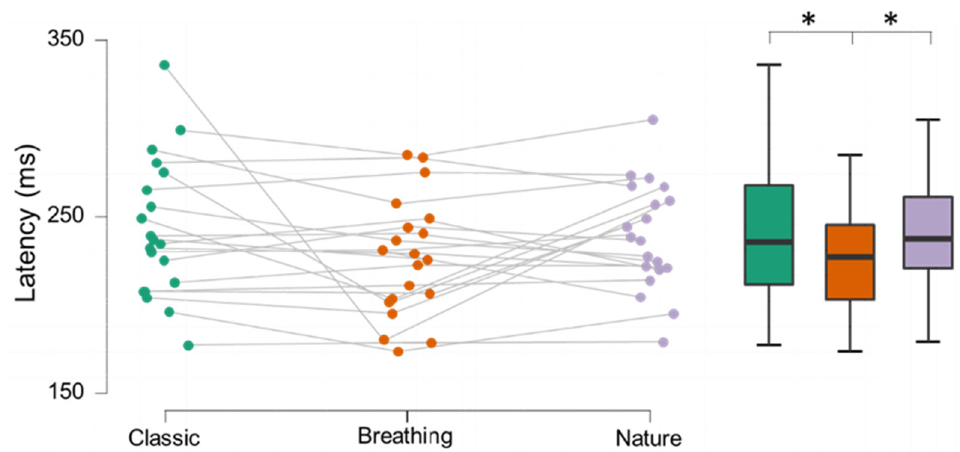
Figure 2. Individual and box plot data for protocol latencies in milliseconds. Breathing showed significantly lower latencies compared to classic (t19 = − 1.826, p = 0.042) and nature protocols (t19 = − 1.801, p = 0.044).